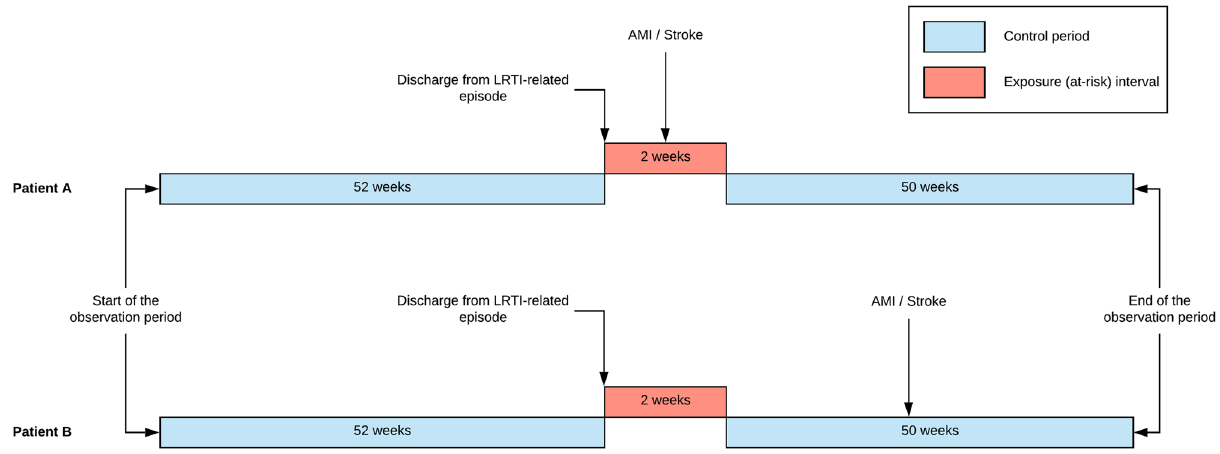
Figure 3. Diagram of the study